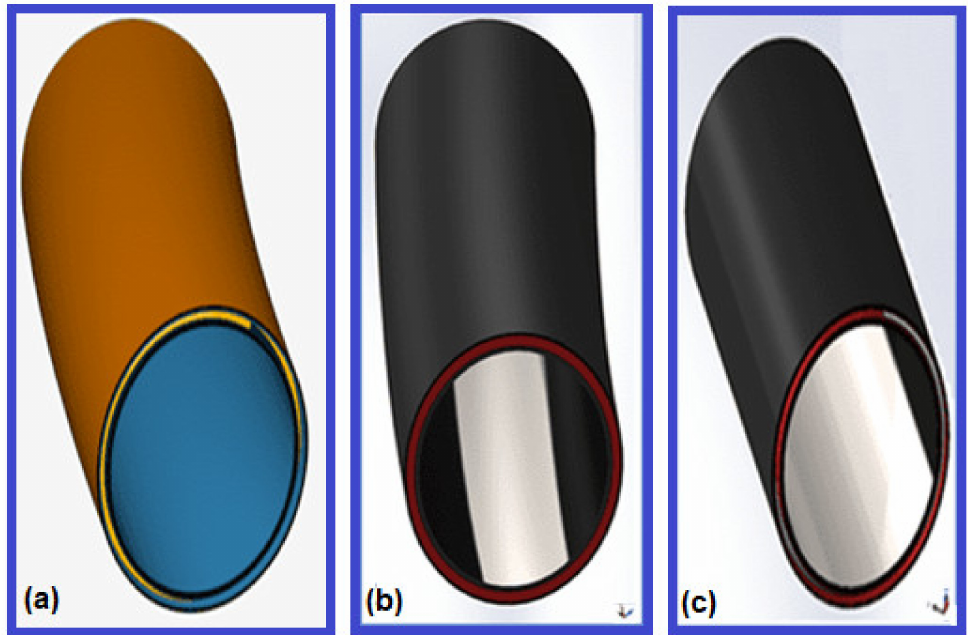
Figure 2. Reeling hose model showing ( a ) reeled section in Simscale OpenFEA, ( b ) reeled section in Solidworks, and ( c ) unreeled sections in